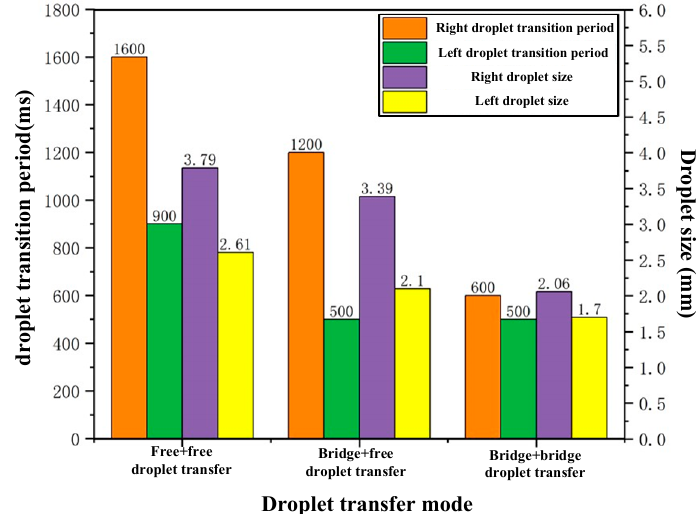
Figure 10. Comparison of three droplet transfer periods and droplet sizes.